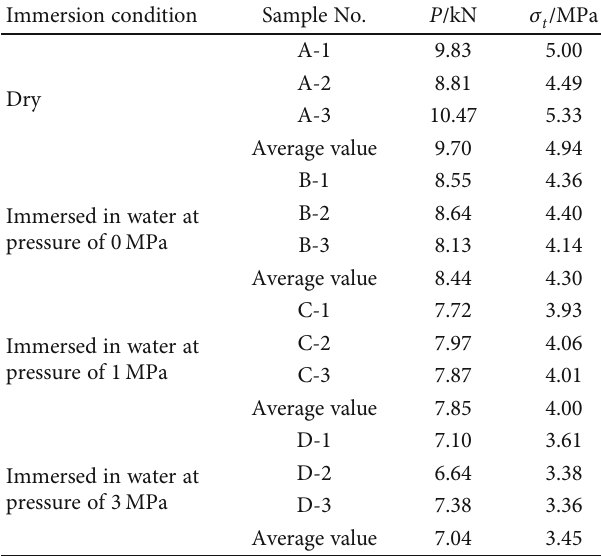
Table 1: Tensile strength test results. Immersion condition Sample No. P /kN σ t